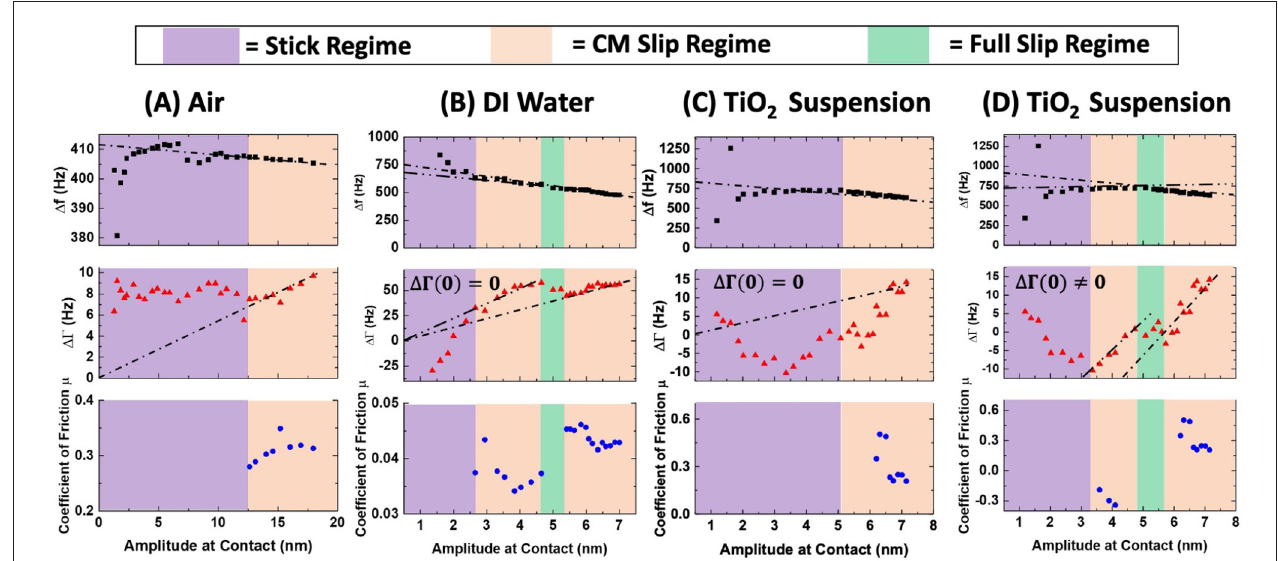
FIGURE 5 | Plots of ∆ f, ∆Γ , and µ vs. QCM amplitude of vibration derived in the CM regime via Method 2, for contacts in (A) air, (B) water and (C,D) the TiO 2 suspension. Regions where ∆ f ( ∆Γ ) decrease (increase) linearly are identified as CM Slip (orange), with displayed with dashed lines. The adjacent regions are designated in purple for regions where the contact is likely to be stuck, and green in regions where the data are consistent with full